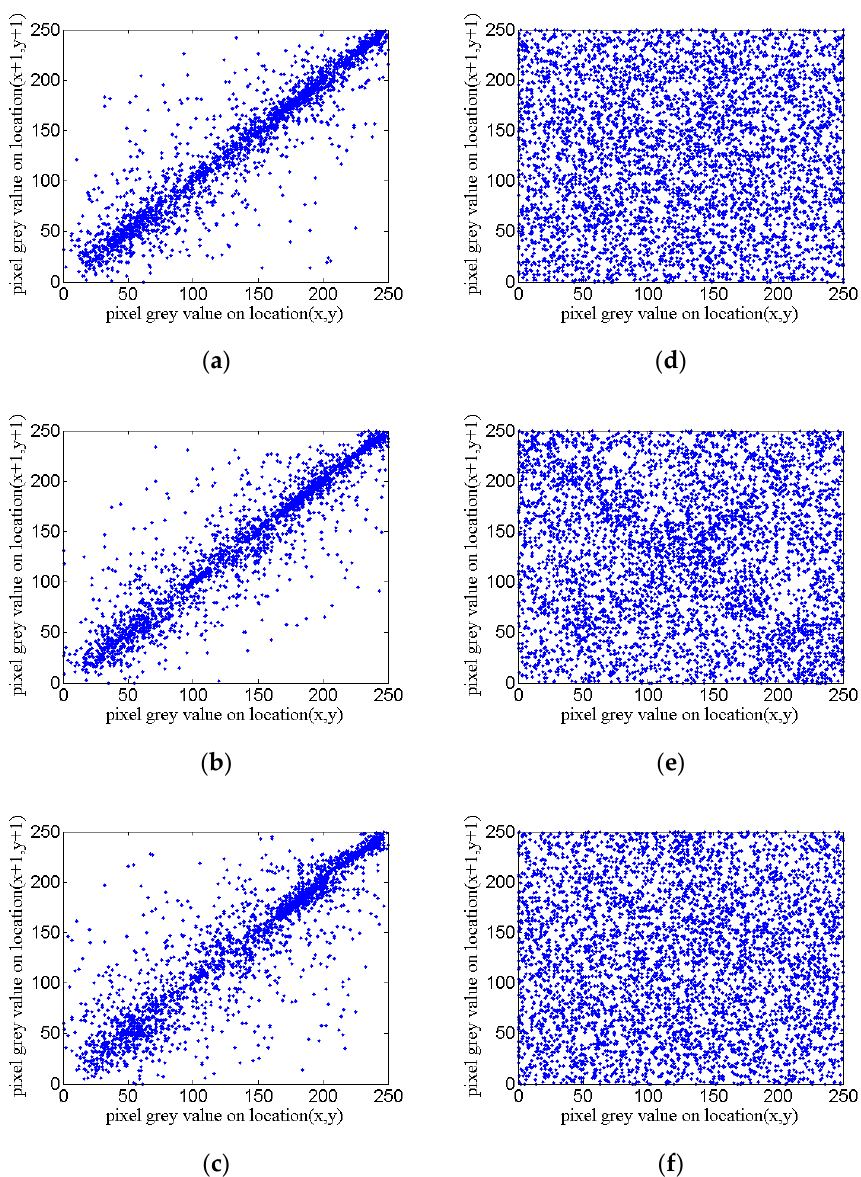
Figure 13. The comparison tests of correlation coefficient before and after cake image encryption: ( a ) the horizontal correlation coefficient before encryption; ( b ) the vertical correlation coefficient before encryption; ( c ) the diagonal correlation coefficient before encryption; ( d ) the horizontal correlation coefficient after encryption; ( e ) the vertical correlation coefficient after encryption; ( f ) the diagonal correlation coefficient after encryption.